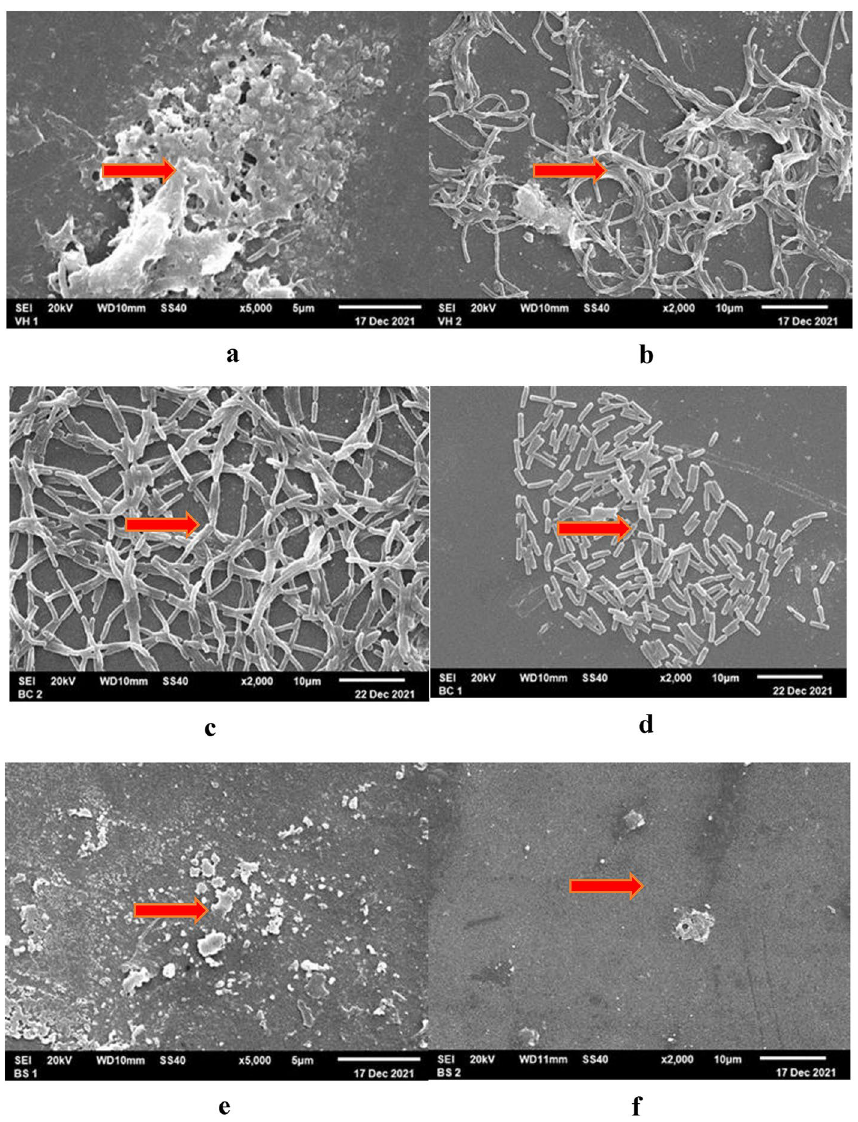
Figure 7. The biofilm structure of V. harveyi ( a ) positive control, ( b ) treated with crude extract of 20 PM isolate; B. cereus ( c ) positive control, ( d ) treated with crude extract of 1AC isolate; and B. subtilis ( e ) positive control, ( f ) treated with crude extract of 18 PM